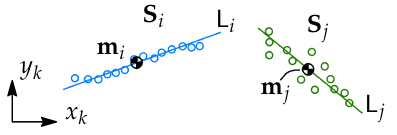
Figure 3. Two examples of point sets S i and S j . Each of the point sets has the center of mass m i or m j and the line fit L i or L j . The point sets are marked with different color and the line fit is shown using the same